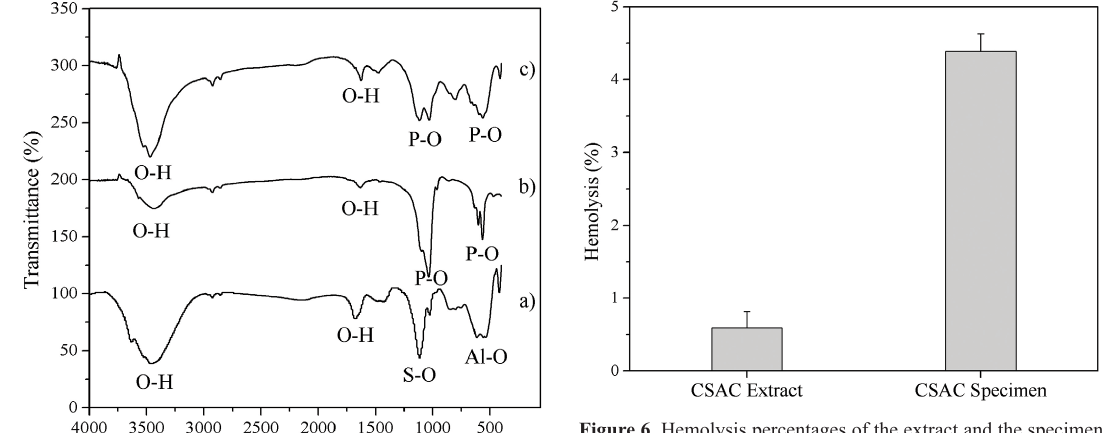
Figure 6. Hemolysis percentages of the extract and the specimen of the calcium sulphoaluminate cement. (PO 4–3 , AsO 4–3 , etc.) to either interact with the ettringite surface or to be ionically exchanged for sulphate ions into the structural